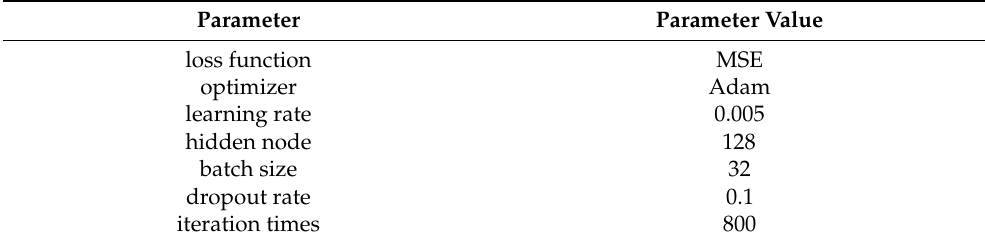
Table 1. Model parameters setting.